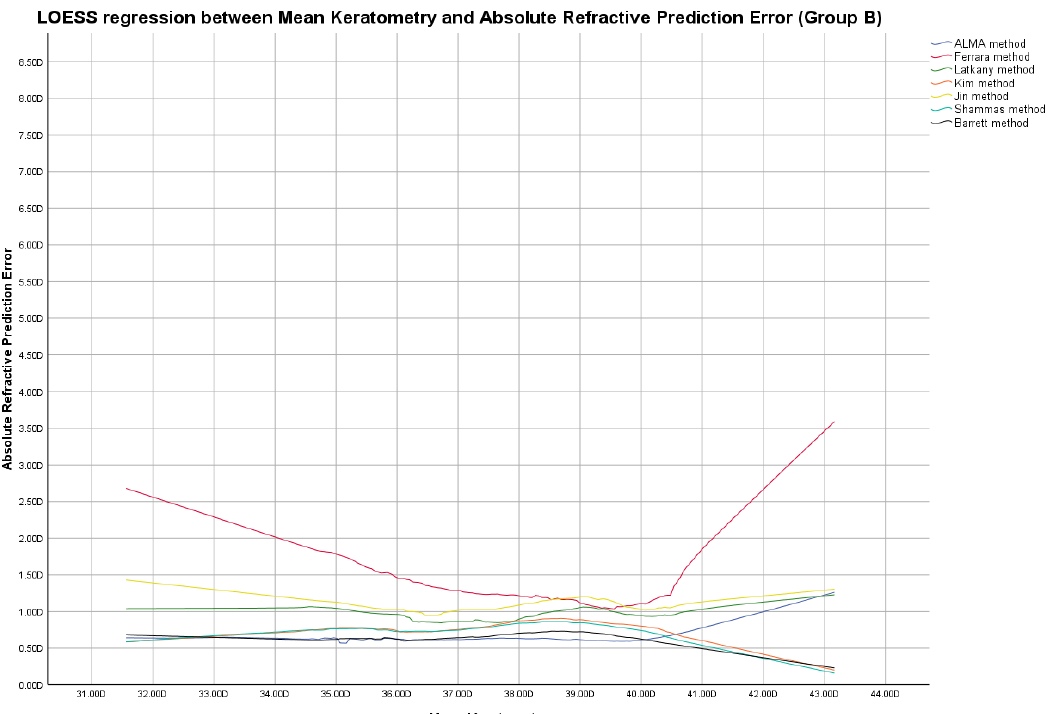
Figure 3. Locally estimated scatterplot smoothing (LOESS) curve between refractive prediction errors generated for each examined formula and the related axial length (AL)/mean keratometry (K) value. (Group A).